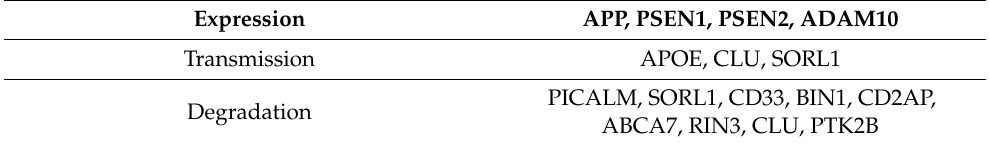
Table 1. Genes linked to A β